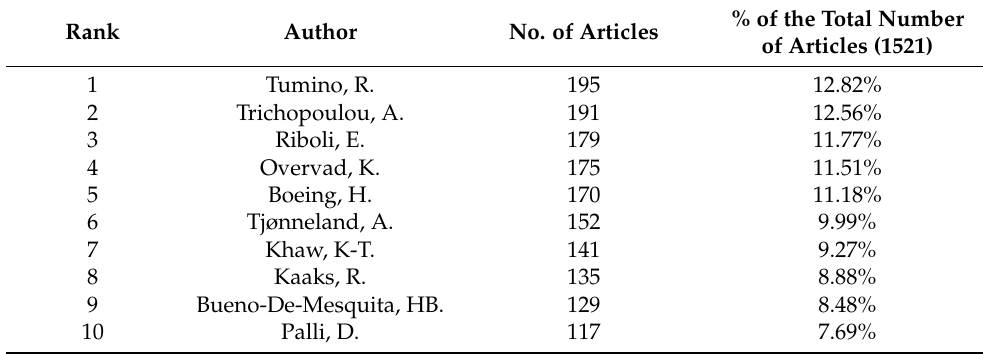
Table 1. Top 10 most productive authors.